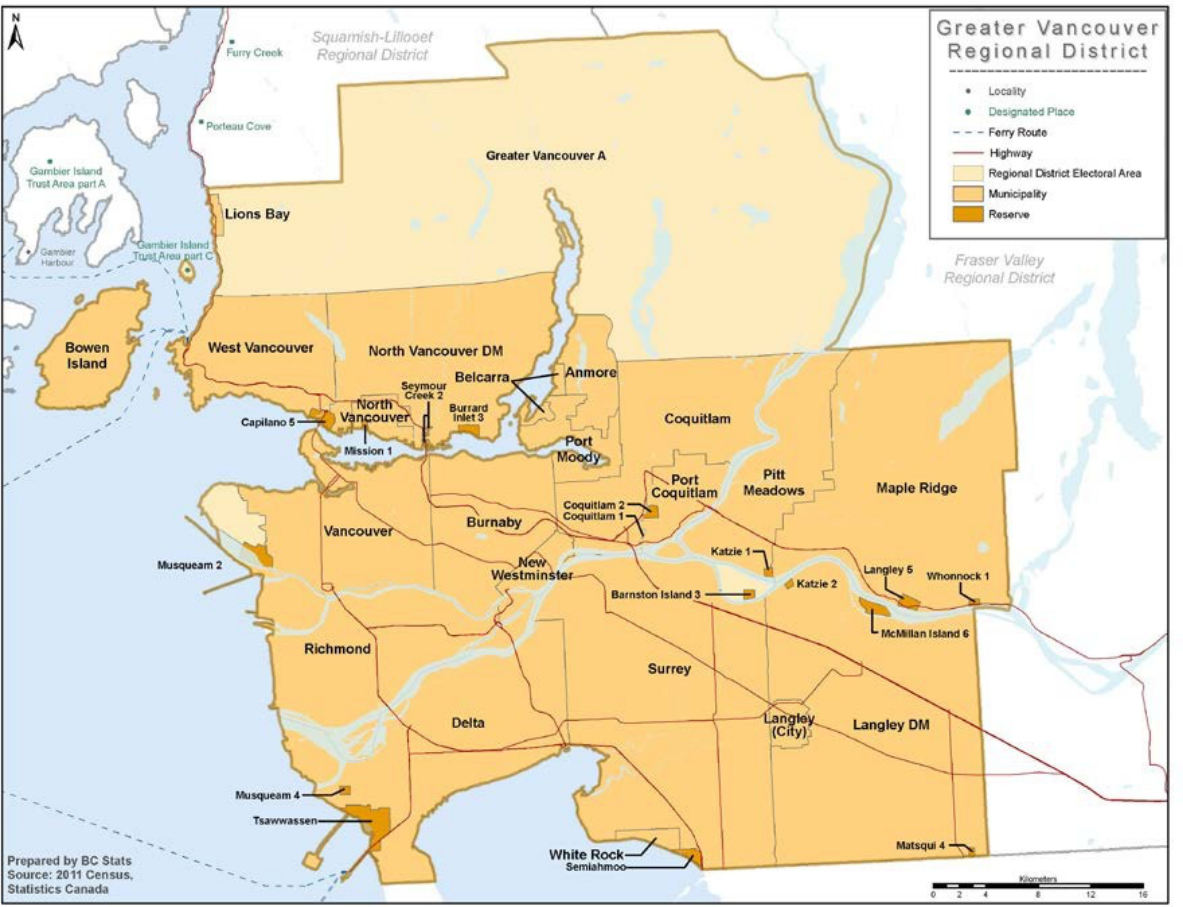
Figure 1. Metropolitan